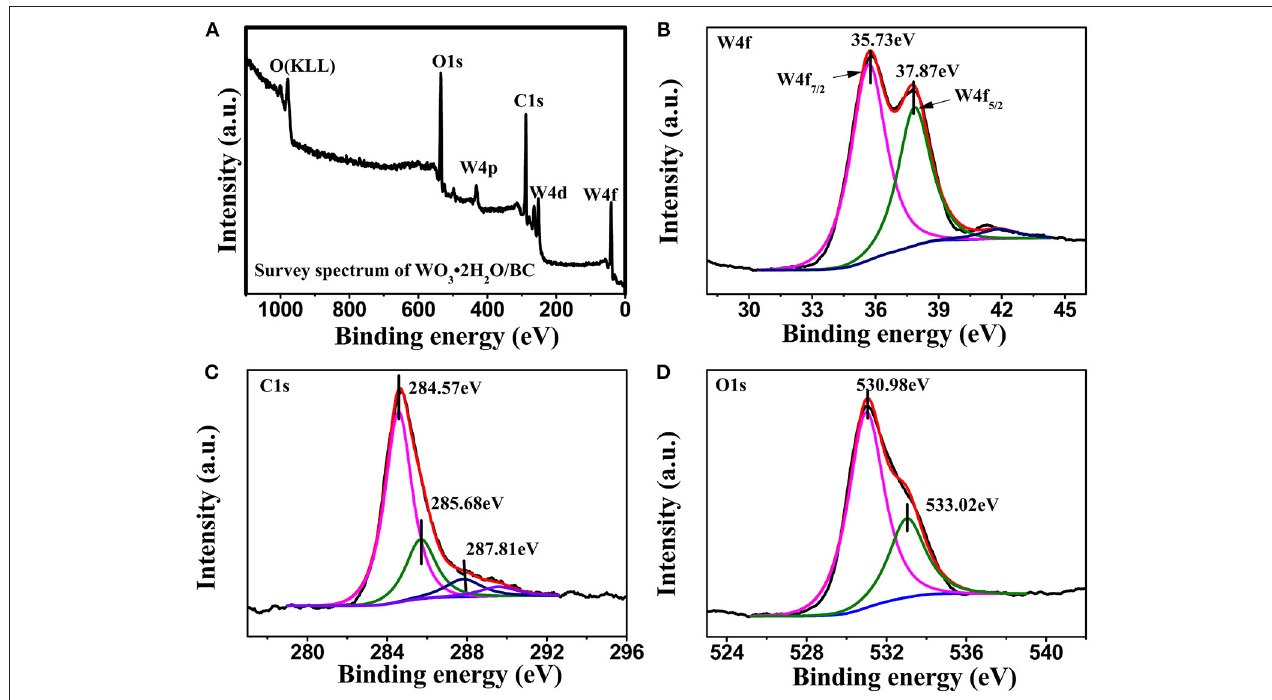
FIGURE 4 | The XPS spectra of WO 3 · 2H 2 O/BC (A) survey scan spectrum, (B) W 4f core level spectrum, (C) C 1s core level spectrum, and (D) O 1s core level spectrum.